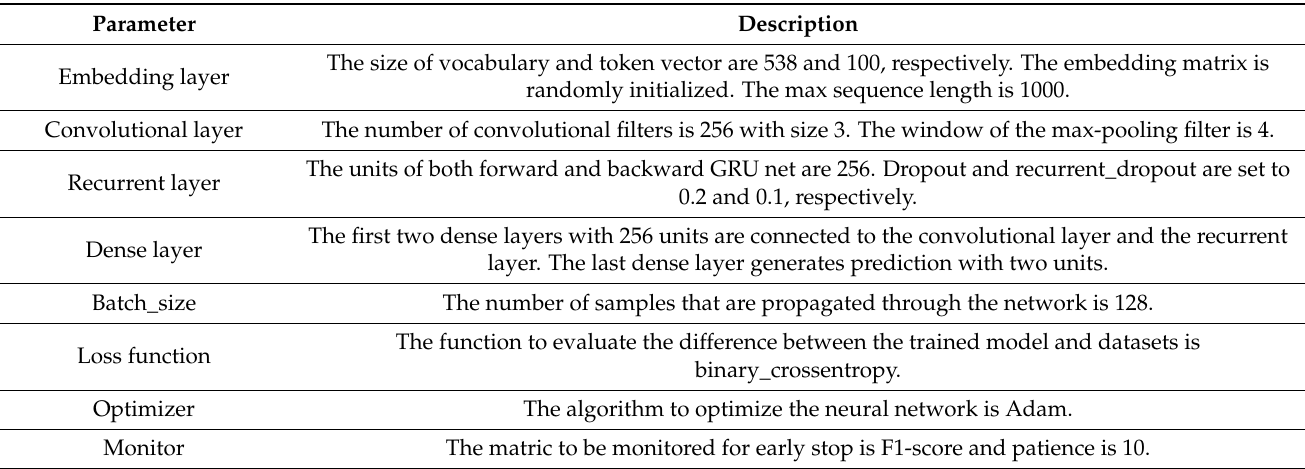
Table 1. Tuned parameters of hybrid neural network.